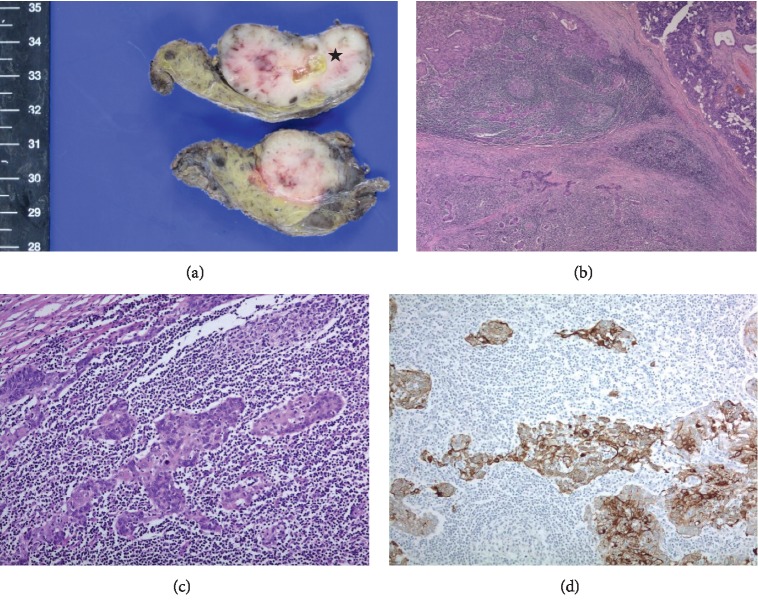
(a) One section of the parotid gland revealed a well-circumscribed and encapsulated tan-to-white solid mass that was seemingly close to the resection margin and measured about 3.5 cm in diameter. The cut surface of the mass showed cystic change that contained sebum-like gelatinous yellow material (asterisk). (b) Microscopically, the tumor in the parotid was composed of variable-sized sebaceous epithelial cell nests and rich lymphoid stroma (×40). (c, d) The epithelial component consisted of solid, variable-sized, and small primitive basaloid cell nests on H&E staining which were immunohistochemically positive for cytokeratin (CK) (×400).